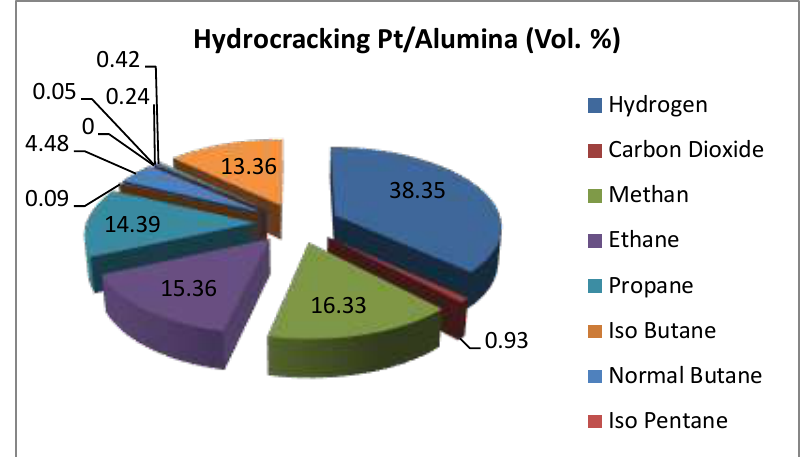
Figure 12: Spectra of hydrocarbons produced in the gas phase from catalytic hydrocracking over Pt/Al 2 O 3